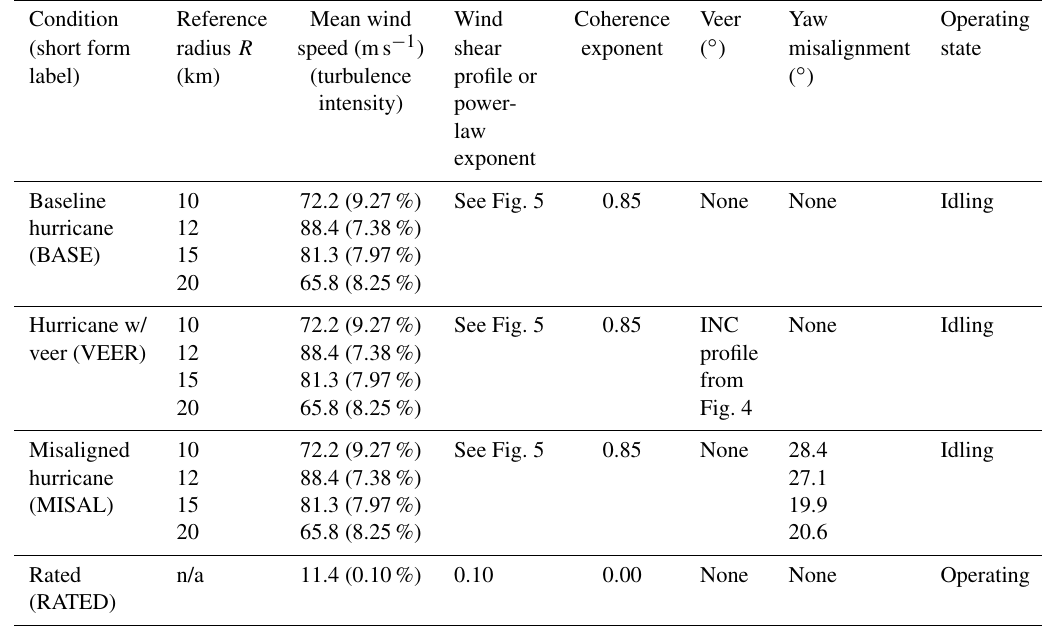
Table 3. Wind field characteristics for the suite of simulation cases (n/a: not applicable). Condition Reference Mean wind Wind